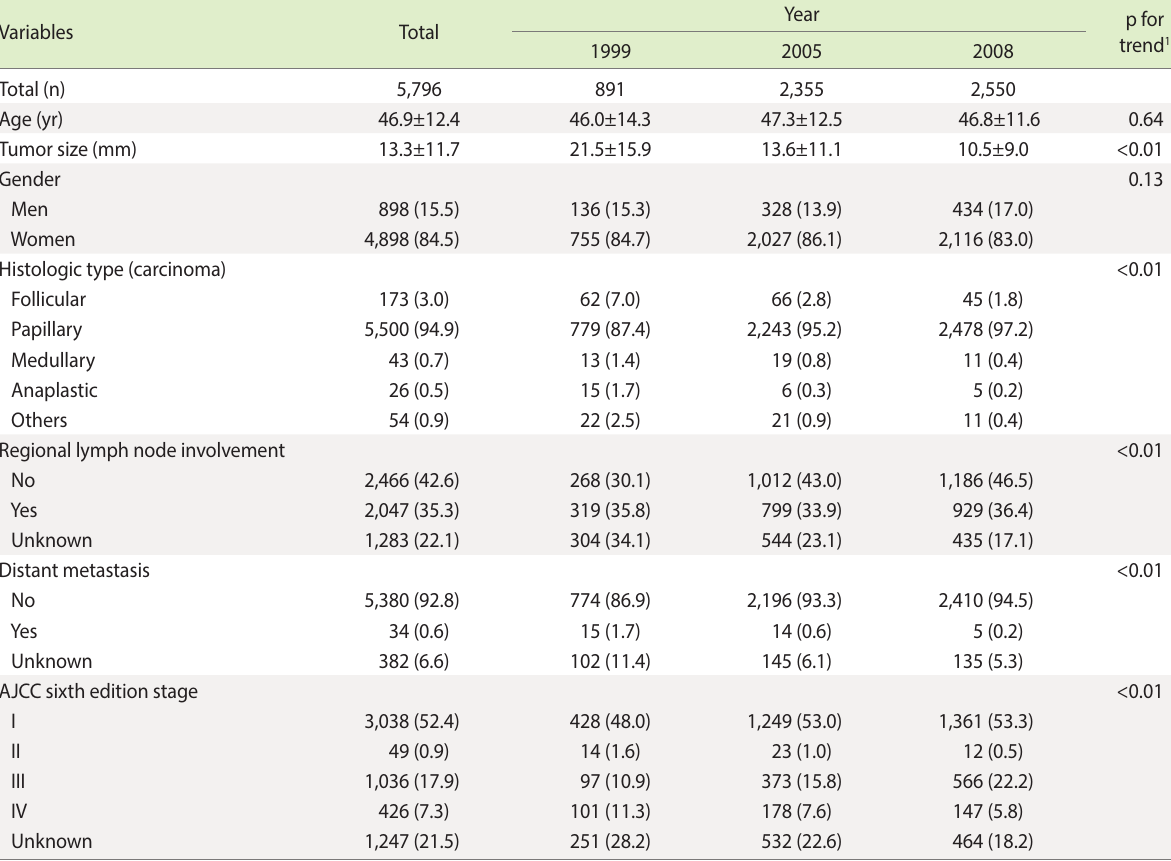
Table 1. Baseline characteristics of study participants with thyroid cancer by year